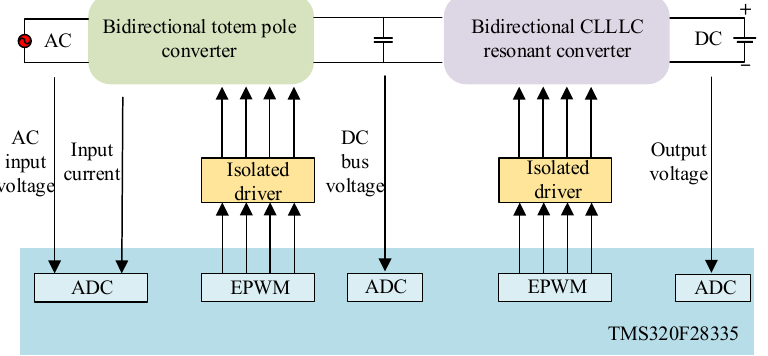
Figure 28. Block diagram of the two-stage bidirectional isolated charging system.